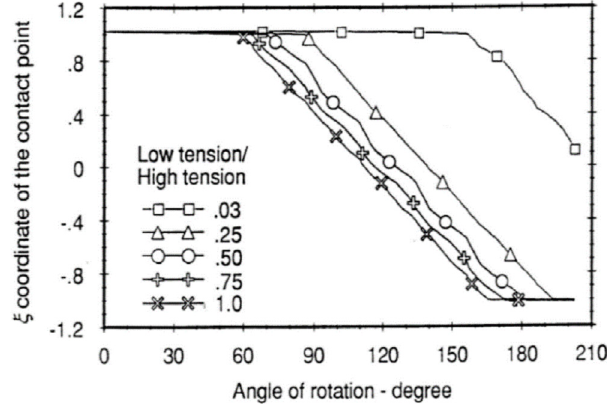
Fig. 18. Location of loss sources.